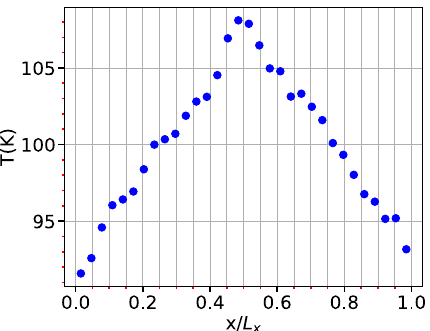
Figure 7. Temperature profile constructed for estimation of thermal conductivity from NEMD method.